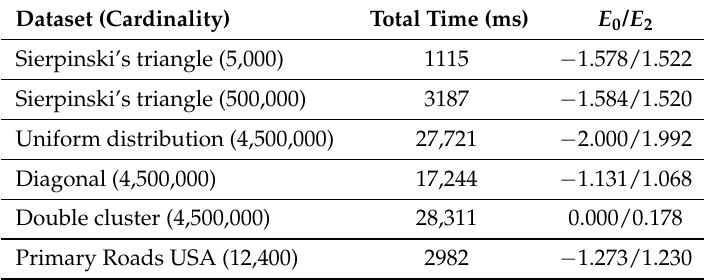
Table 3. Algorithm application for the computation of E 0 and E 2